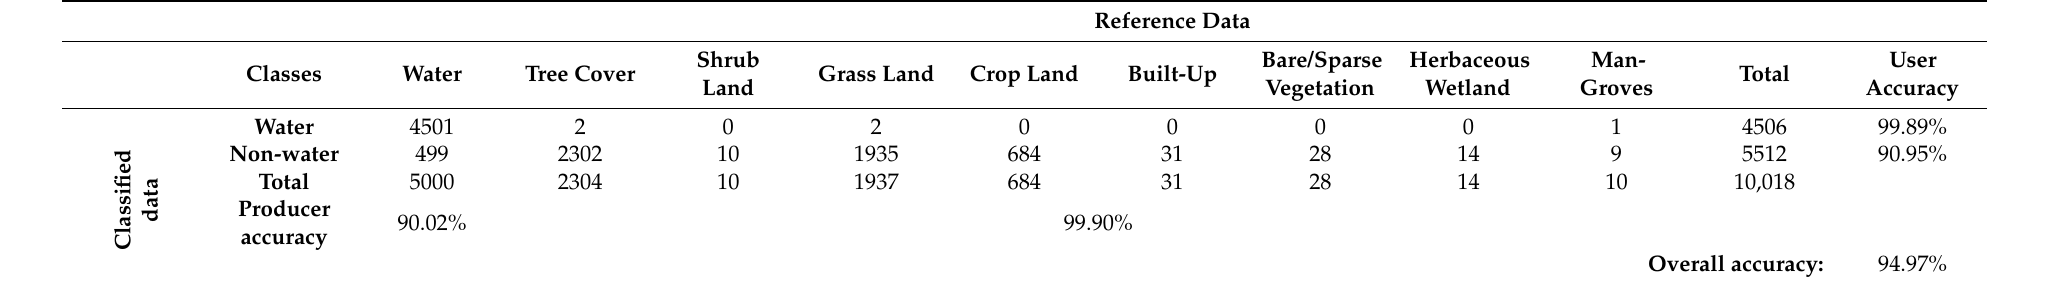
Table 6. Accuracy assessment results for CAWI with a slope mask.